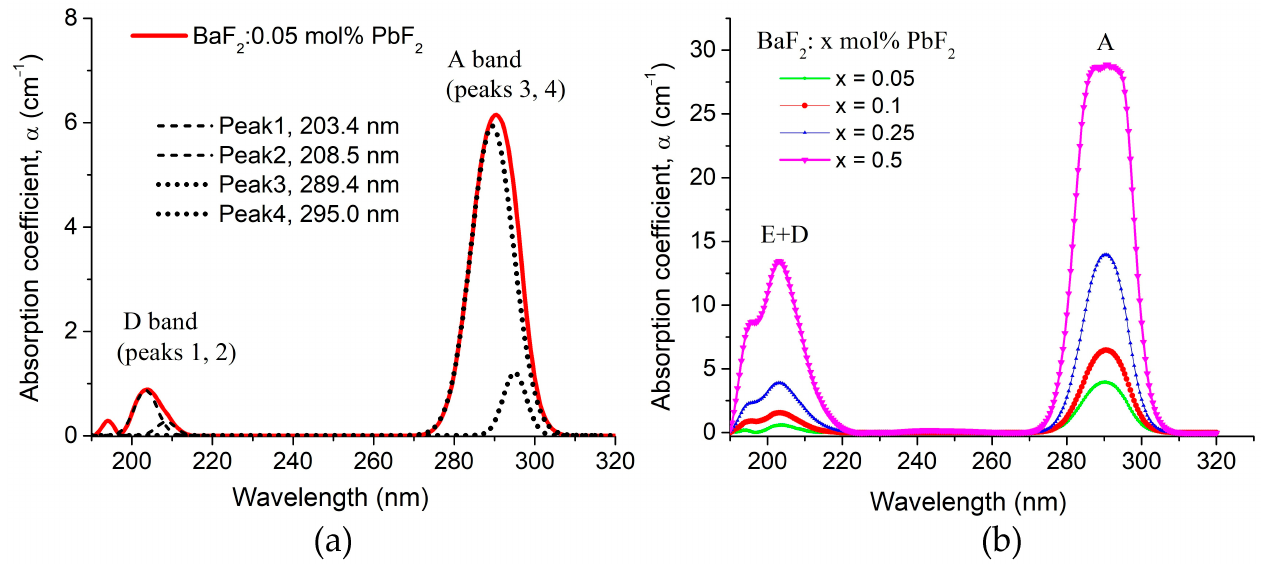
Figure 4. Optical absorption spectra. ( a ) Influence of PbF 2 concentration on the absorption spectra; ( b ) Gaussian multi-peak fitting of the absorption spectrum of BaF 2 : 0.05 mol% PbF 2 sample. As the Pb 2+ ion concentration increased, the A band conserved its shape but the shape of the D band modified (Figure 4b). For all concentrations, the A band was the